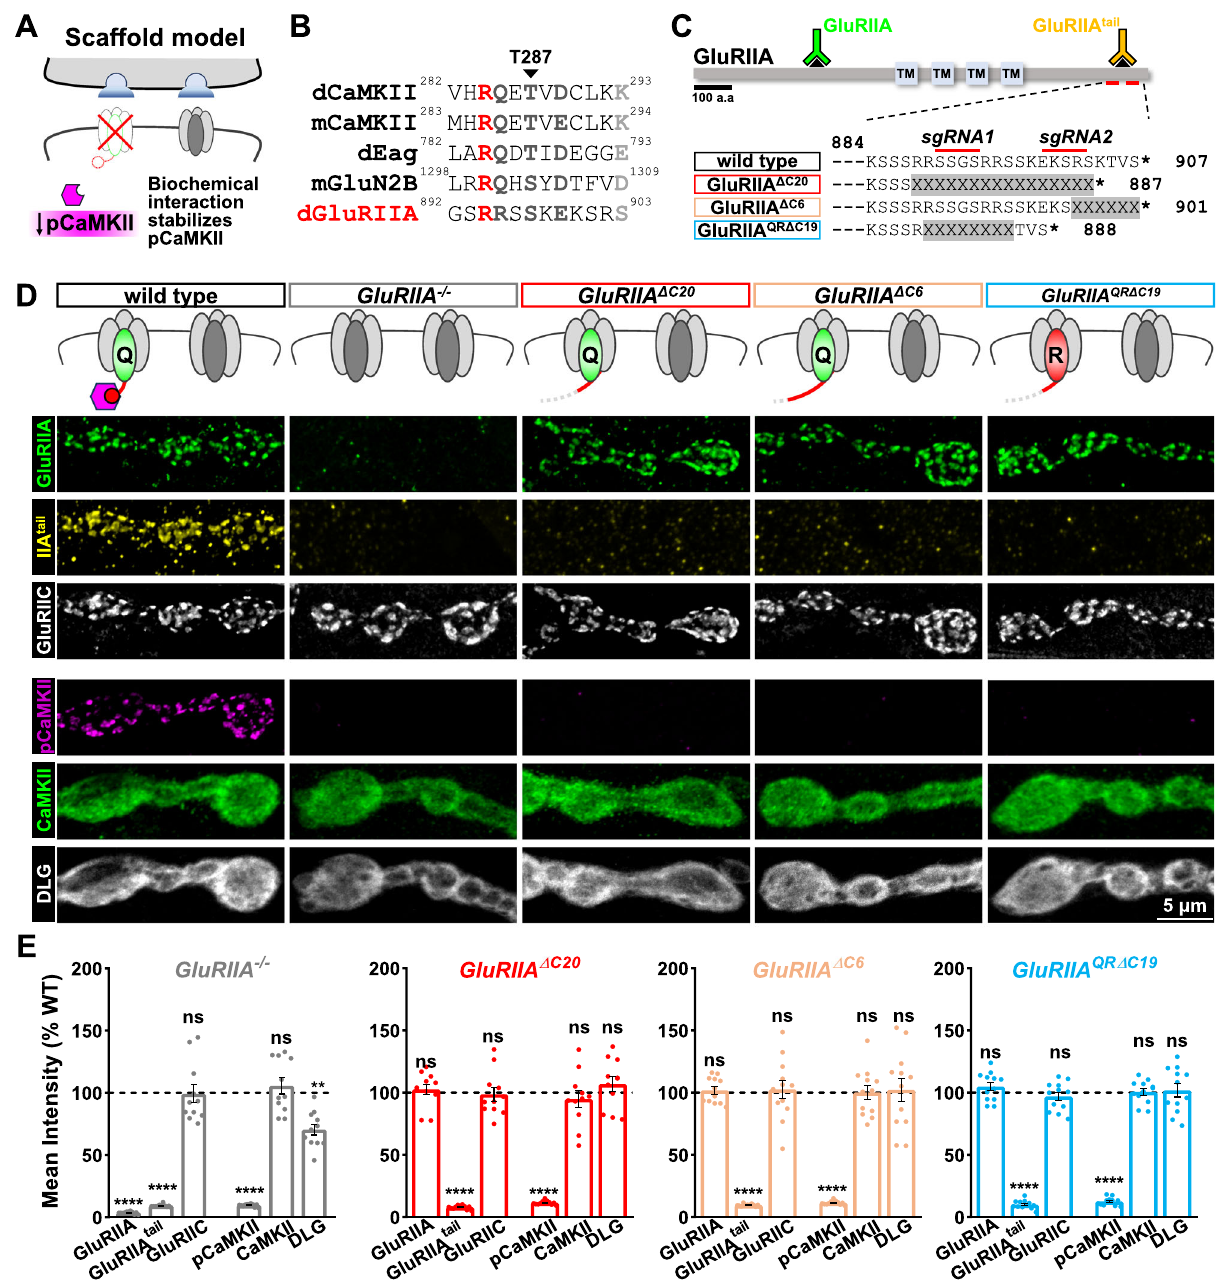
GluRIIA QR Δ C19 , and ( w ; GluRIIA QR Δ C19 ). Experiments were repeated three times inde- pendently with similarresults. Note thatthe loss of the terminal six amino acids of the GluRIIA C-tail is suf fi cient to completely lose pCaMKII signals. E Quanti fi cation of mean fl uorescence intensities of the indicated antibody signal normalized to wild-type values (wild type: n =12; GluRIIA − / − , n =12, p <0.0001 for GluRIIA, p <0.0001forGluRIIA tail , p =0.9912forGluRIIC, p <0.0001forpCaMKII, p =0.9958 for CaMKII, p =0.0022 for DLG; GluRIIA Δ C20 : n =12, p =0.1744 for GluRIIA, p <0.0001forGluRIIA tail , p =0.9912forGluRIIC, p <0.0001forpCaMKII, p =0.9958 for CaMKII, p =0.0022 for DLG; GluRIIA Δ C6 : n =12, p =0.6019 for GluRIIA, p <0.0001forGluRIIA tail , p =0.9912forGluRIIC, p <0.0001forpCaMKII, p =0.9958 for CaMKII, p =0.0022 for DLG; GluRIIA QR Δ C19 : n =12, p =0.9967 for GluRIIA, p <0.0001forGluRIIA tail , p =0.9912forGluRIIC, p <0.0001forpCaMKII, p =0.9958 forCaMKII, p =0.0022forDLG).Errorbarsindicate±SEM.* p <0.05,**** p <0.0001; ns,notsigni fi cant. n valuesindicatebiologicallyindependentNMJs.Sourcedataare provided as a Source Data fi